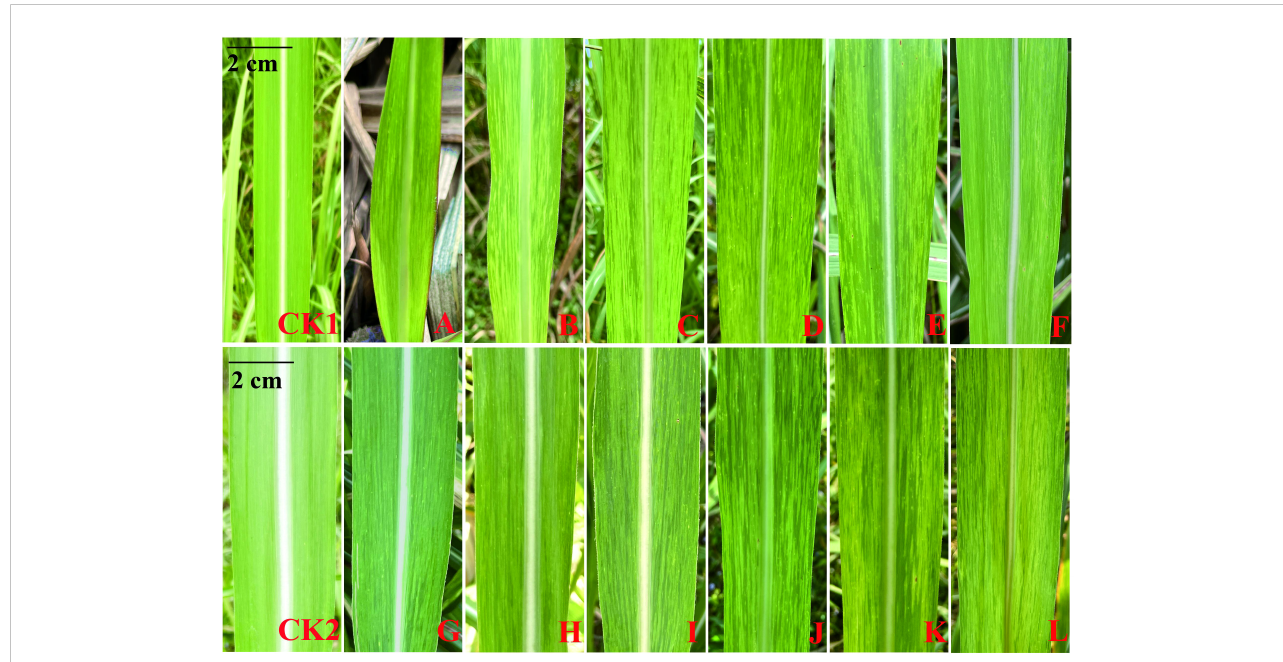
FIGURE 2 SMD symptoms of a highly susceptible progeny (FN14-255) observed in different months CK1: disease free control (January); CK2: disease free control (December); (A – L) : January-December,